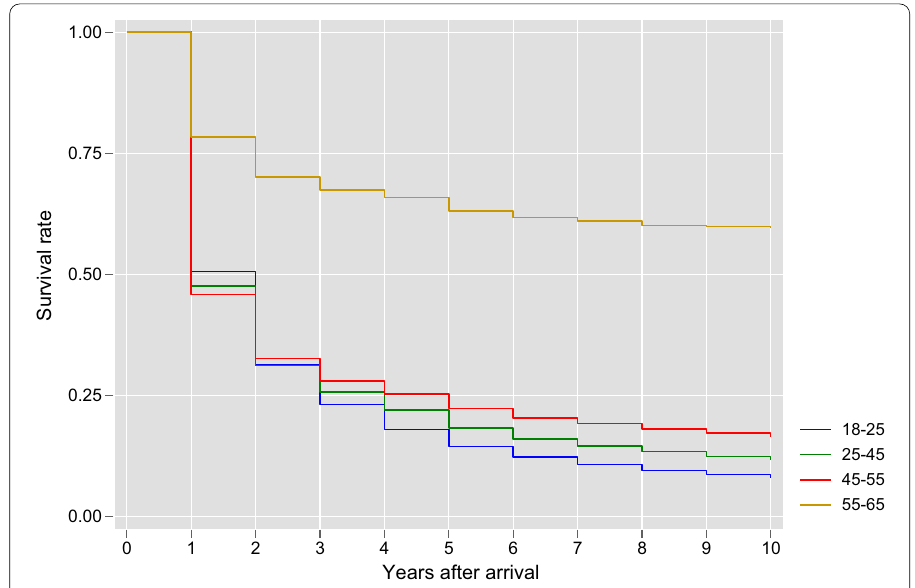
Fig. 5 Kaplan–Meier survival functions of not being registered, by age at